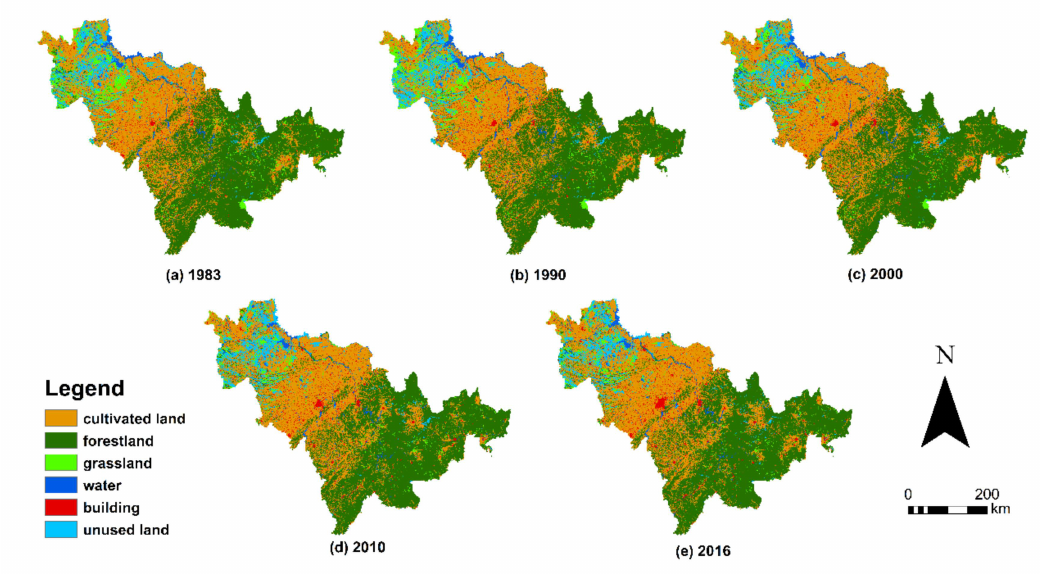
Figure 2. The land use maps of Jilin province in ( a ) 1983, ( b ) 1990, ( c ) 2000, ( d ) 2010, and ( e ) 2016, reclassified into six